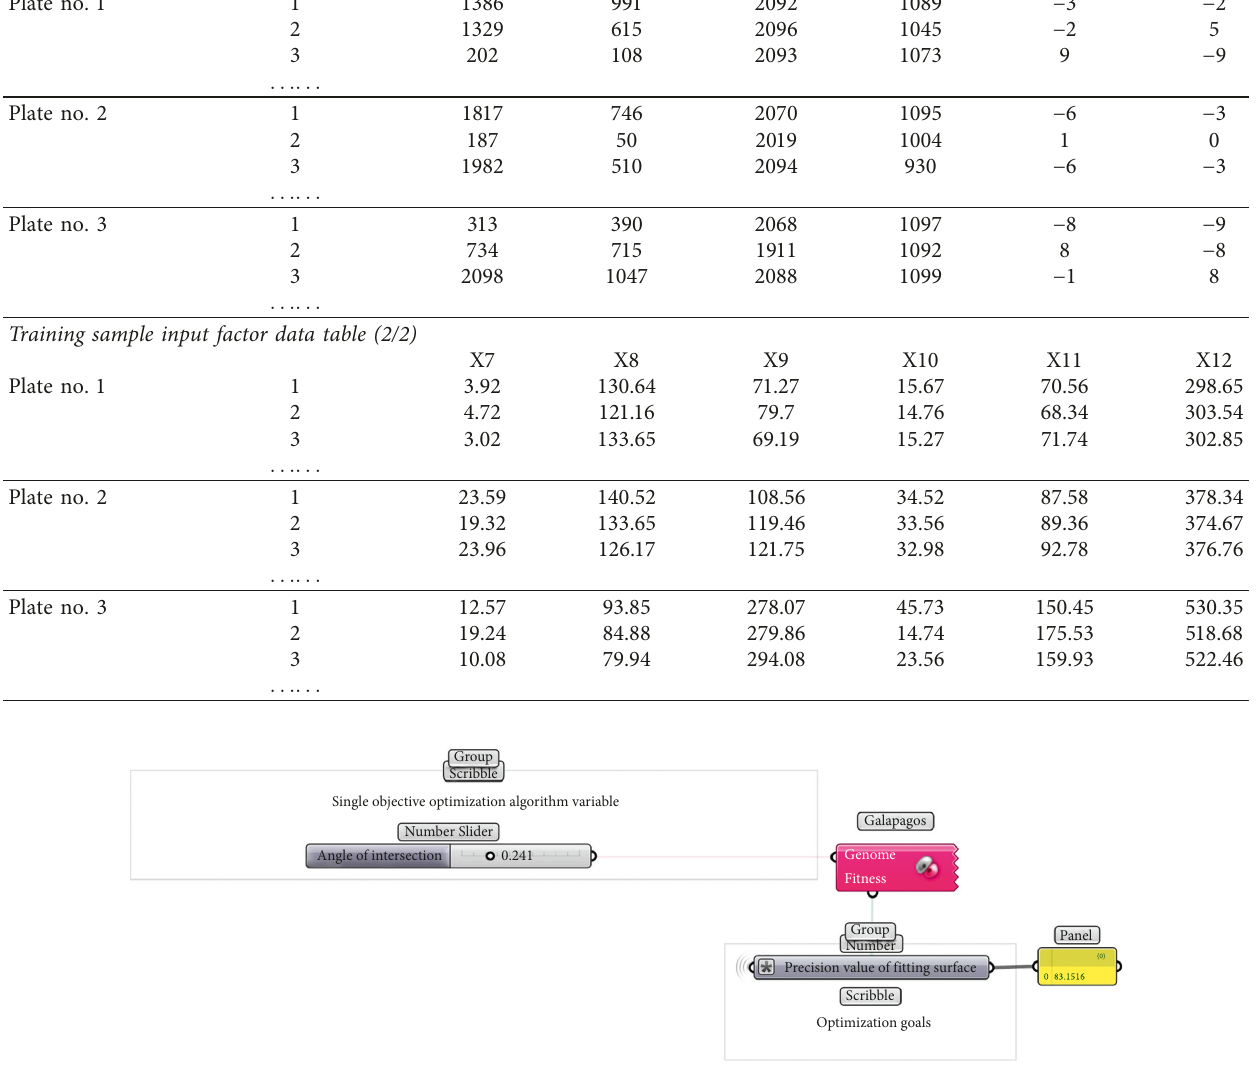
Figure 10: External connection of “Galapagos”